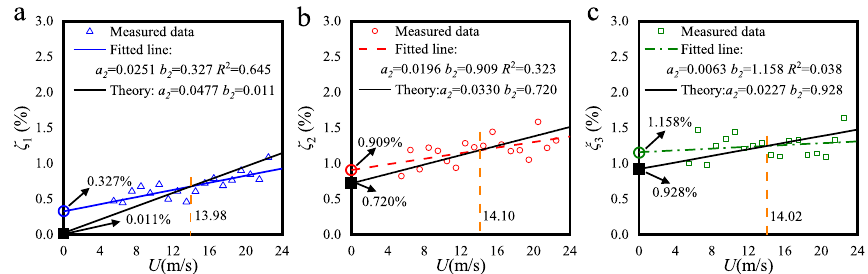
Fig. 17 Relationship between measured modal damping ratios and wind velocity in first three vertical bendings of PSRB using EWT-HT: a First-order; b Second-order; c